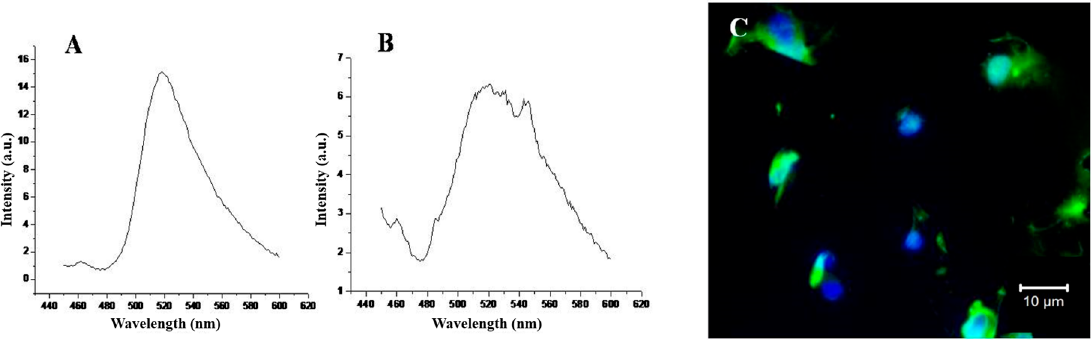
Figure 4. Fluorescence characterization: ( A ) Chitosan grafted oleic acid; ( B ) assembled structure of Hybrid Polymeric Lipid Protein Nano-carriers (HPLPNCs); and ( C ) cellular uptake.